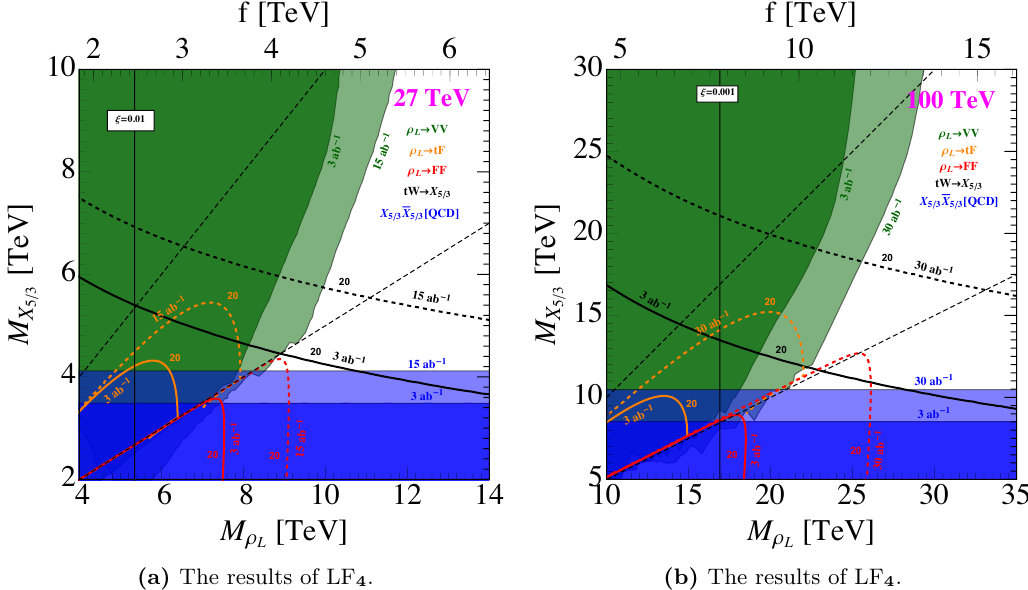
Figure 11. Left: the prospective reaches at the 27 TeV HE-LHC with integrated luminosities 3 ab (cid:0) 1 and 15 ab (cid:0) 1 ; right: the prospective reaches at the 100 TeV pp collider with integrated lumi- nosities 3 ab (cid:0) 1 and 30 ab (cid:0) 1 . The parameters and conventions are the same as (cid:12)gure